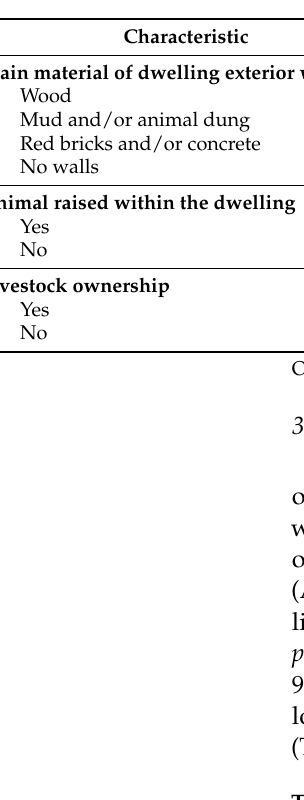
Table 2. Individual risk factors for mycetoma at Eastern Sennar locality, Sennar State (n =